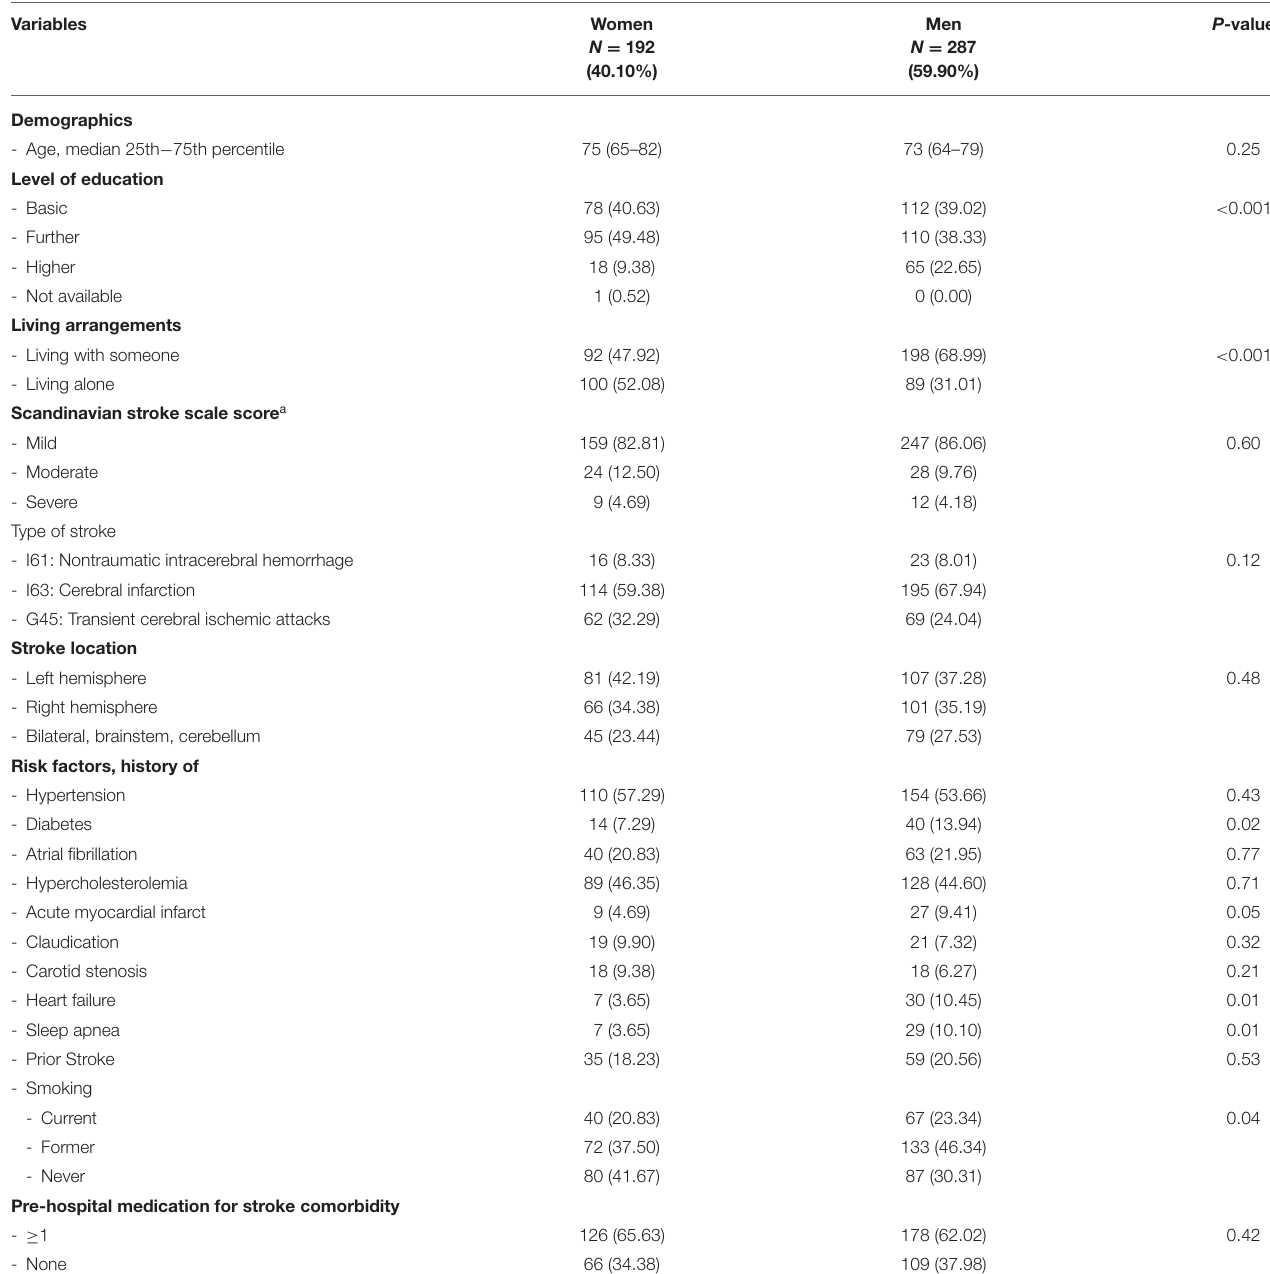
TABLE 1 | Patient